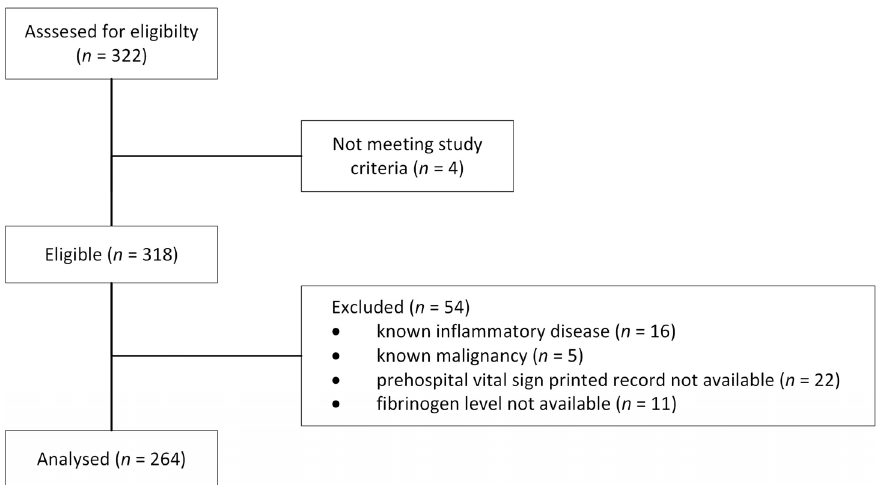
Figure 1. Enrolment flow diagram. Table 2. Study population demographic and clinical characteristics. Data are presented as number (%), mean (SD) or median (IQR) values.